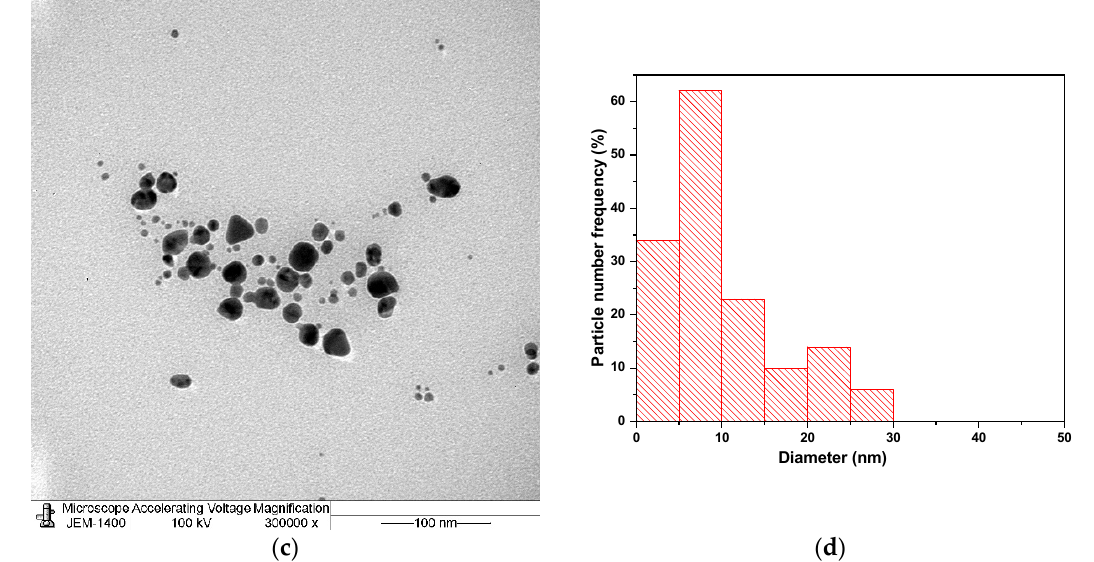
Figure 7. ( a , c ) TEM images of Ag NPs without and with laser irradiation, respectively. ( b , d ) The size distribution of these particles, correspondingly.